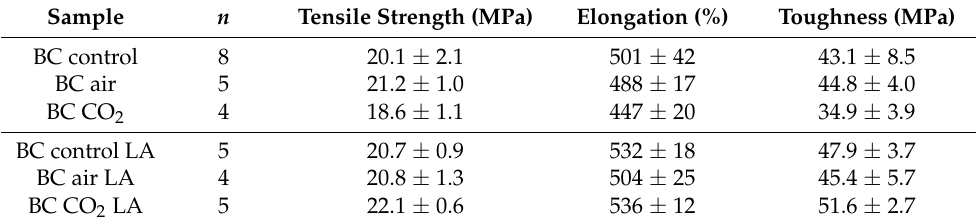
Table 4. Tensile properties of uncoated and 10% LA-coated biochar